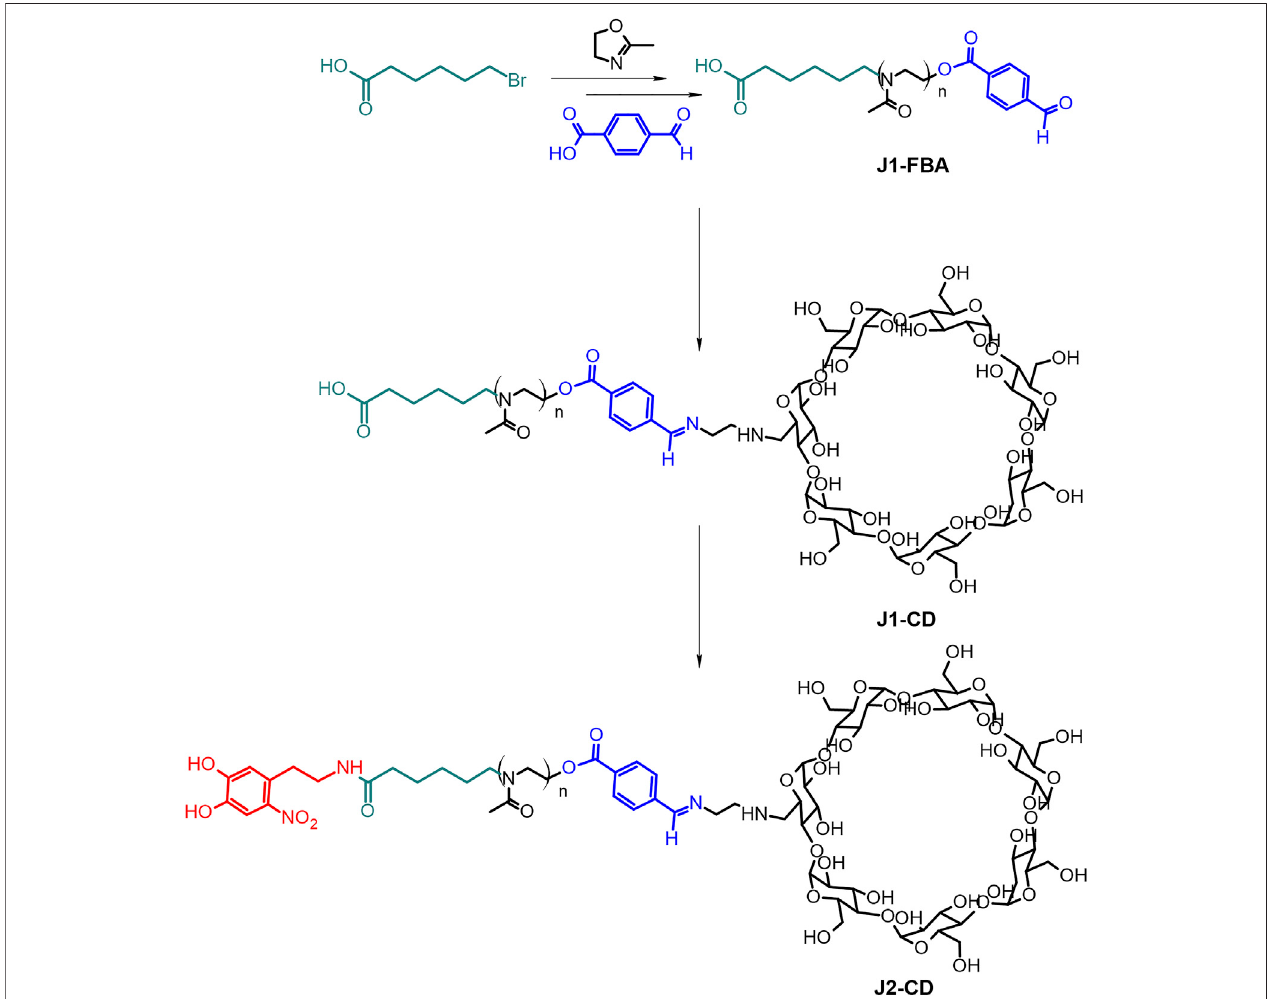
FIGURE 2 | General scheme of synthesis of the bi-functional polymer.